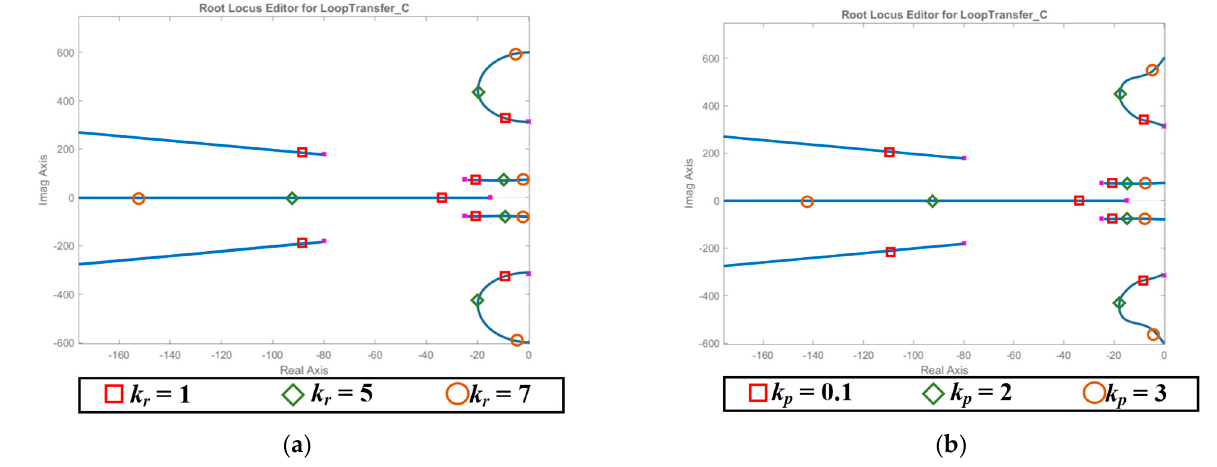
Figure 22. Pole-zero maps of the PR controller of Mode 3: ( a ) k p = 0.5 and k r = [1:7], and ( b ) k r = 5 and k p = [0.1:3].